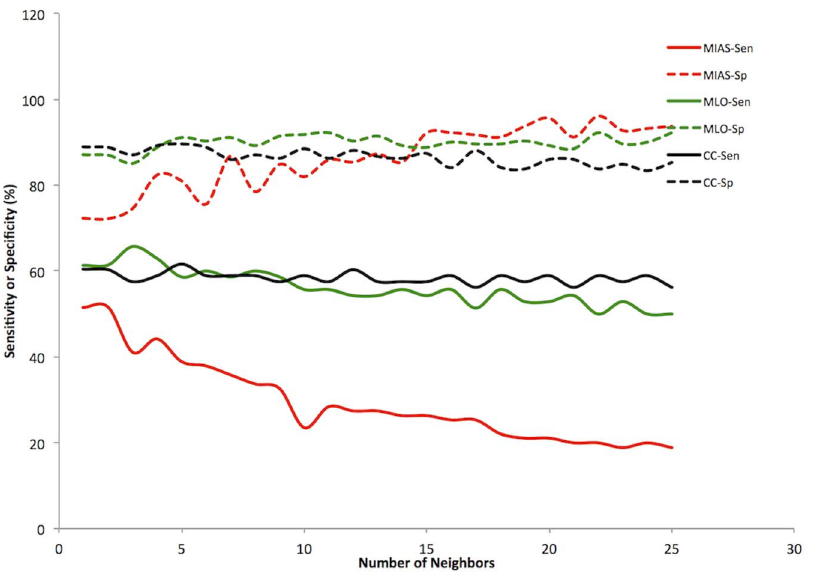
doi:10.1371/journal.pone.0091015.g002